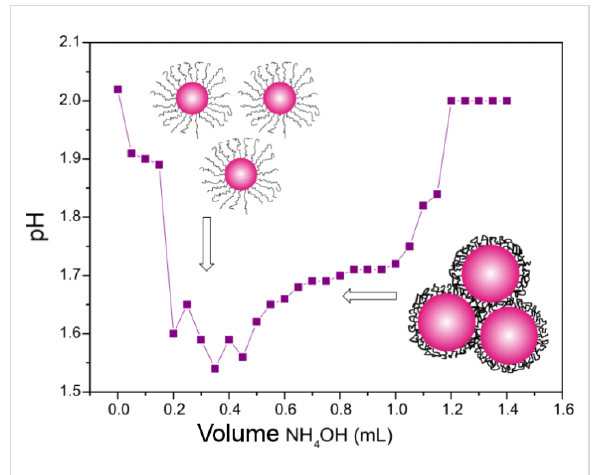
Figure 9: pH change as a function of the amount of precipitating agent (ammonium hydroxide) added.